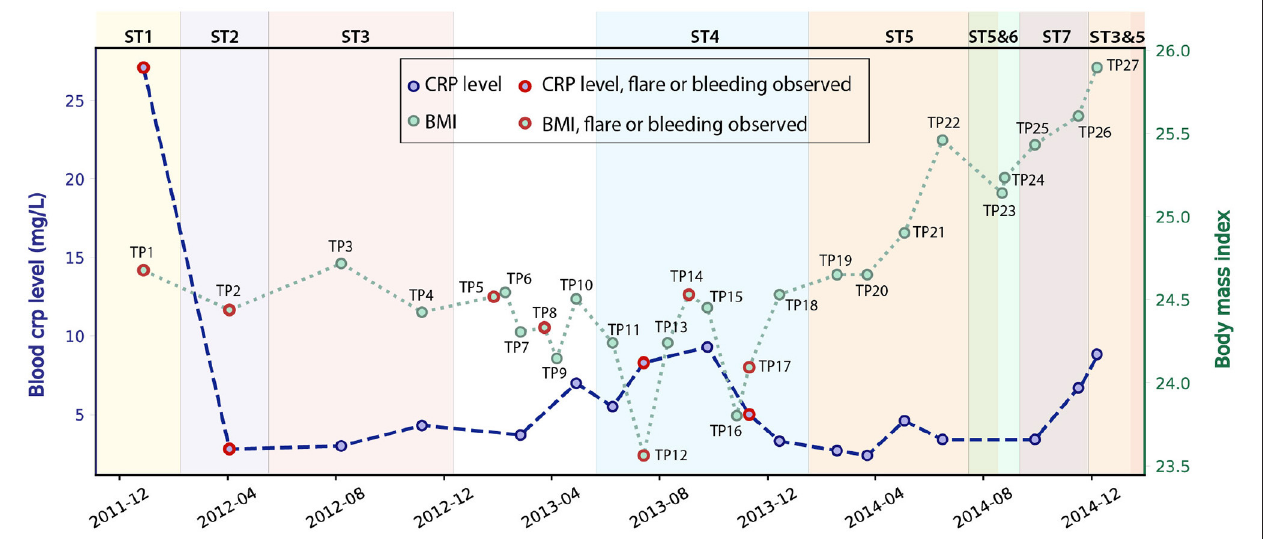
FIGURE 1 | Blood hs-CRP level and BMI of the patient fluctuated during the 3 years of this study (hs-CRP only available for 18 samples). Samples collected during bleeding or flare are labeled in red. The dominant E. coli strain varied for different time points (discussed in the next paragraph), and are labeled by different background